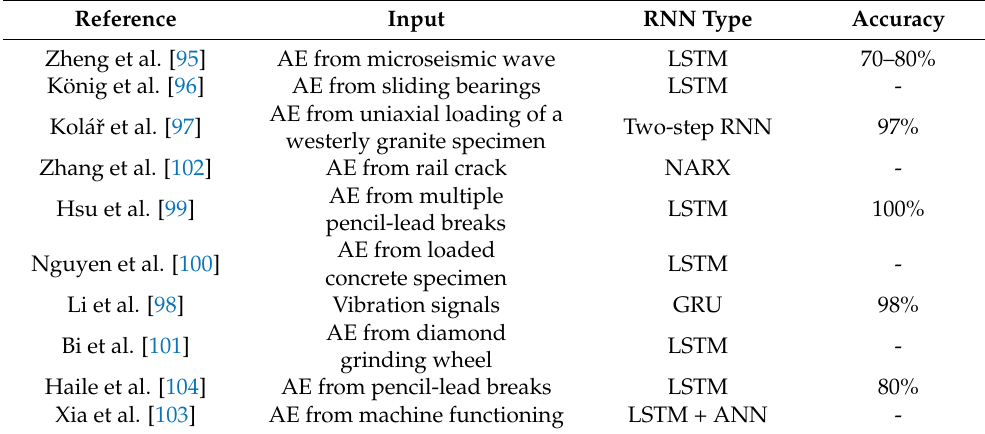
Table 4. RNN-based methods for AE